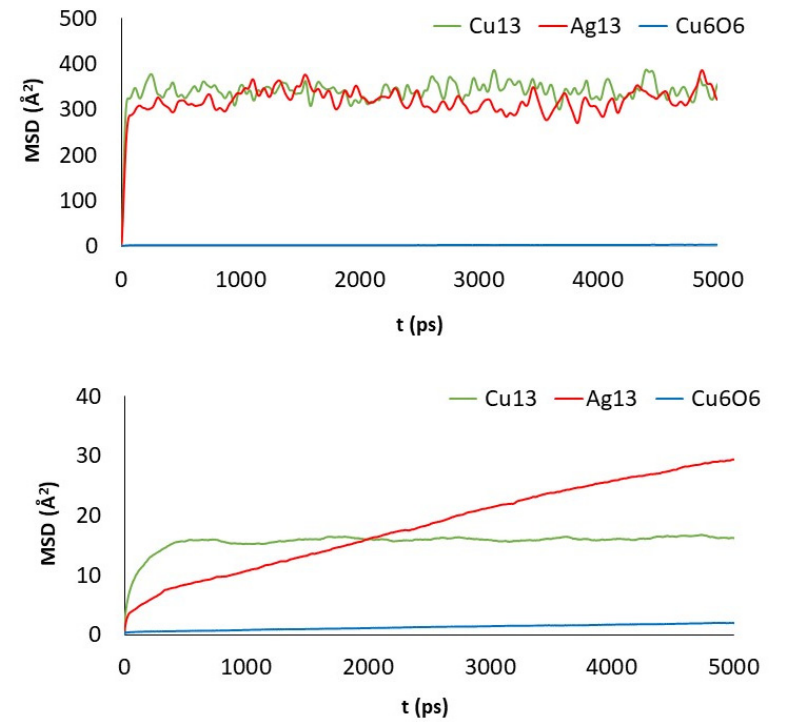
Figure 6. MSD of the clusters versus simulation length: PG (top) and GO_PEG (bottom).